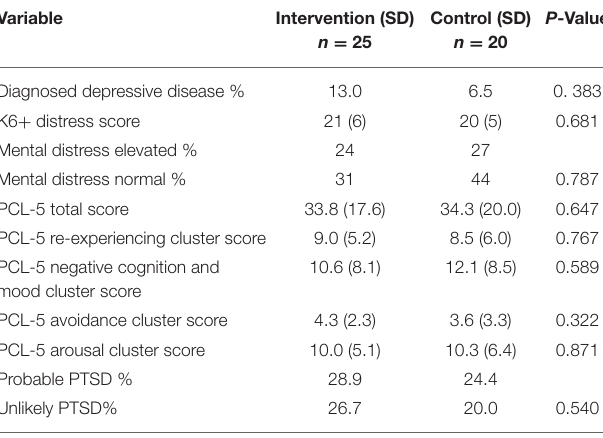
TABLE 2 | Baseline mental health-related characteristics of participants in a dance-movement